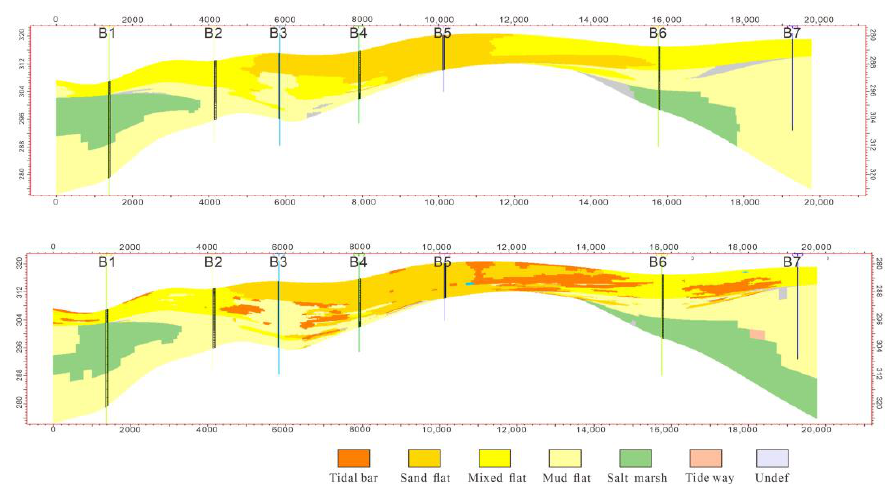
Figure 13. Comparison test of modeling results.